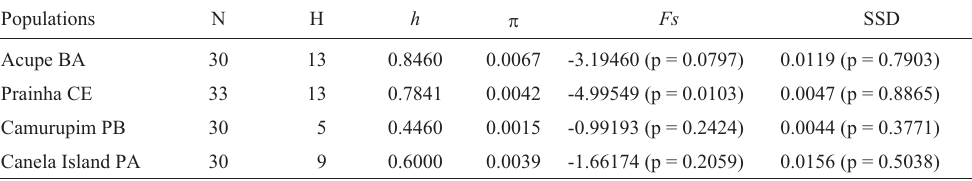
Table 2 - Cytochrome oxidase c subunit I (COI) diversity, mutation neutrality test results and mismatch analysis for each population. Populations